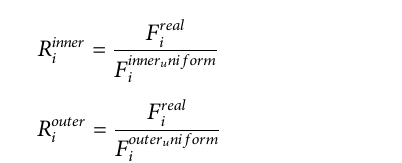
Frontiers in Energy Research |